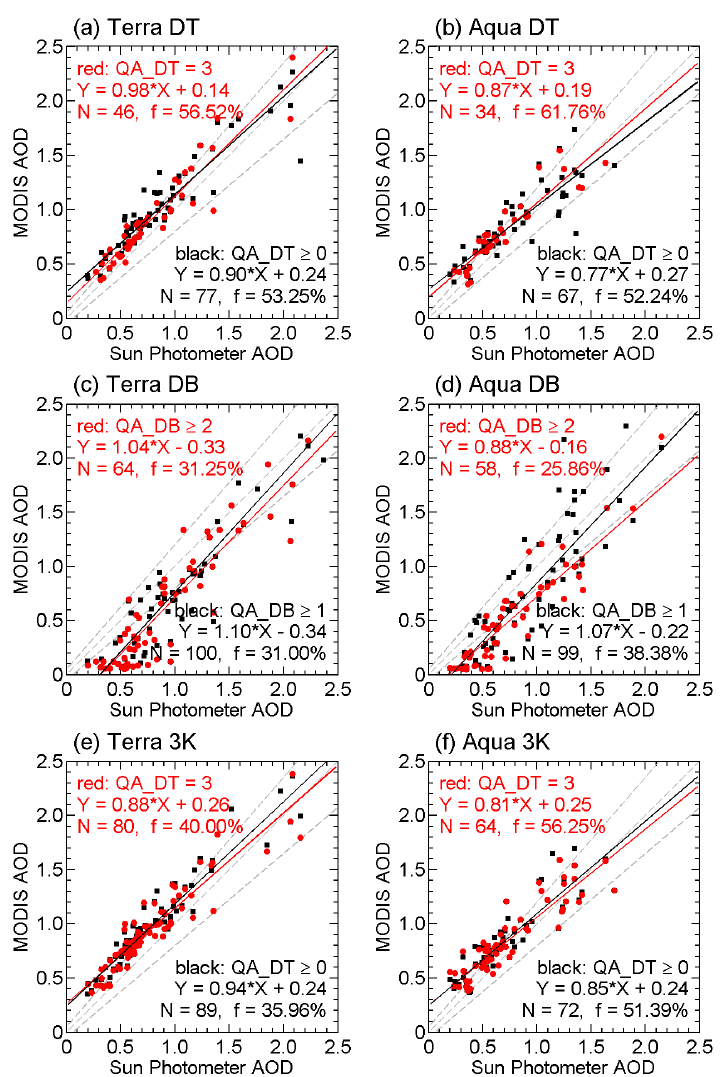
Figure 2. Scatterplots with the sun photometer AODs and ( a ) Terra 10 km Dark Target (DT) AODs; ( b ) Aqua 10 km DT AODs; ( c ) Terra Deep Blue (DB) AODs; ( d ) Aqua DB AODs; ( e ) Terra 3 km DT AODs; ( f ) Aqua 3 km DT AODs. The red dots (black squares) represent MODIS AODs with good (all) quality. The gray dashed lines are the expected errors (EE) of ±(0.05 + 15%) and 1:1 line. The red (black) solid lines are the linear regressions of red dots (black squares). The regression equations, number of matchups (N) and fractions of matchups falling in EE ( f ) are presented in texts.